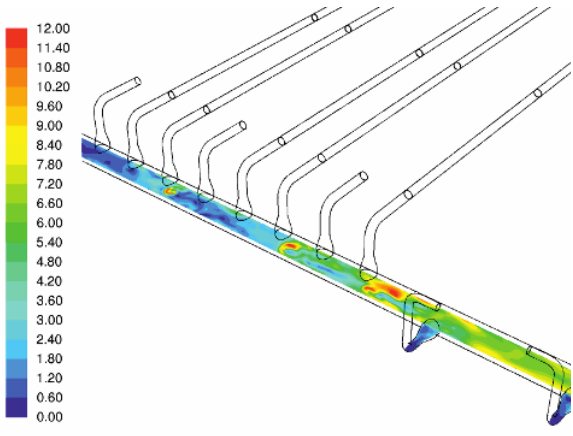
Figure 11: Velocity field behind metering runs